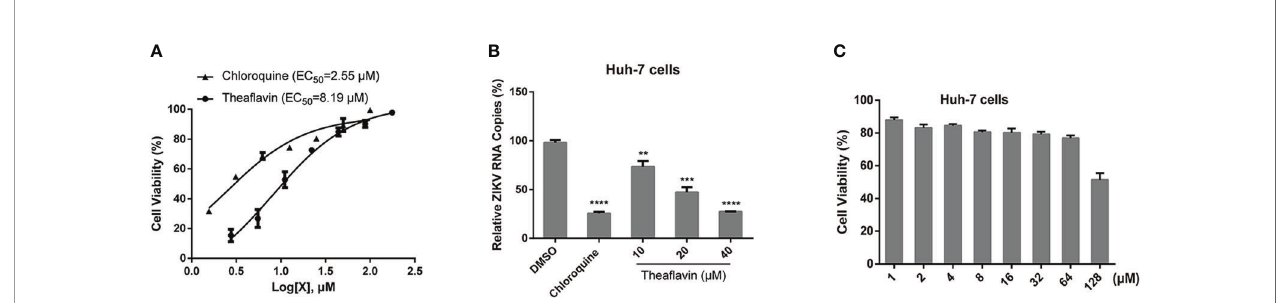
FIGURE 5 | The thea fl avin inhibits ZIKV infection with low cytotoxicity. (A) Dose dependent inhibition of ZIKV by thea fl avin in Huh7 cells. Chloroquine was used as a positive control. (B) qRT-PCR analyses of viral RNA inhibition by thea fl avin in Huh7 cells. **P < 0.01, ***P < 0.001, ****P < 0.0001. Data were shown as the mearn ± SD (N = 3). (C) Cytotoxicity of thea fl avin. Huh7 cells were treated with different concentrations of thea fl avin (1-128 m M). The cell viability was measured by CCK-8